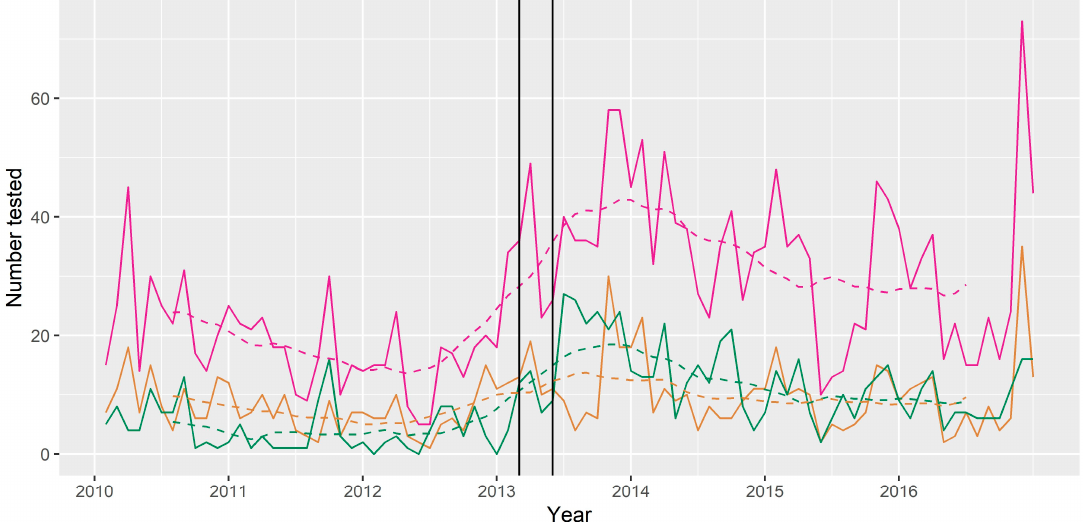
Figure 6. Number of bats tested for ABLV per month (trend—broken line) 2010–2016. Pink = all bats tested; green = bats with dog contact; tan = bats with human contact. Year ticks represent 1st January (mid-summer). The two vertical black lines represent the timing of the human case and the horse cases, which both received media attention.